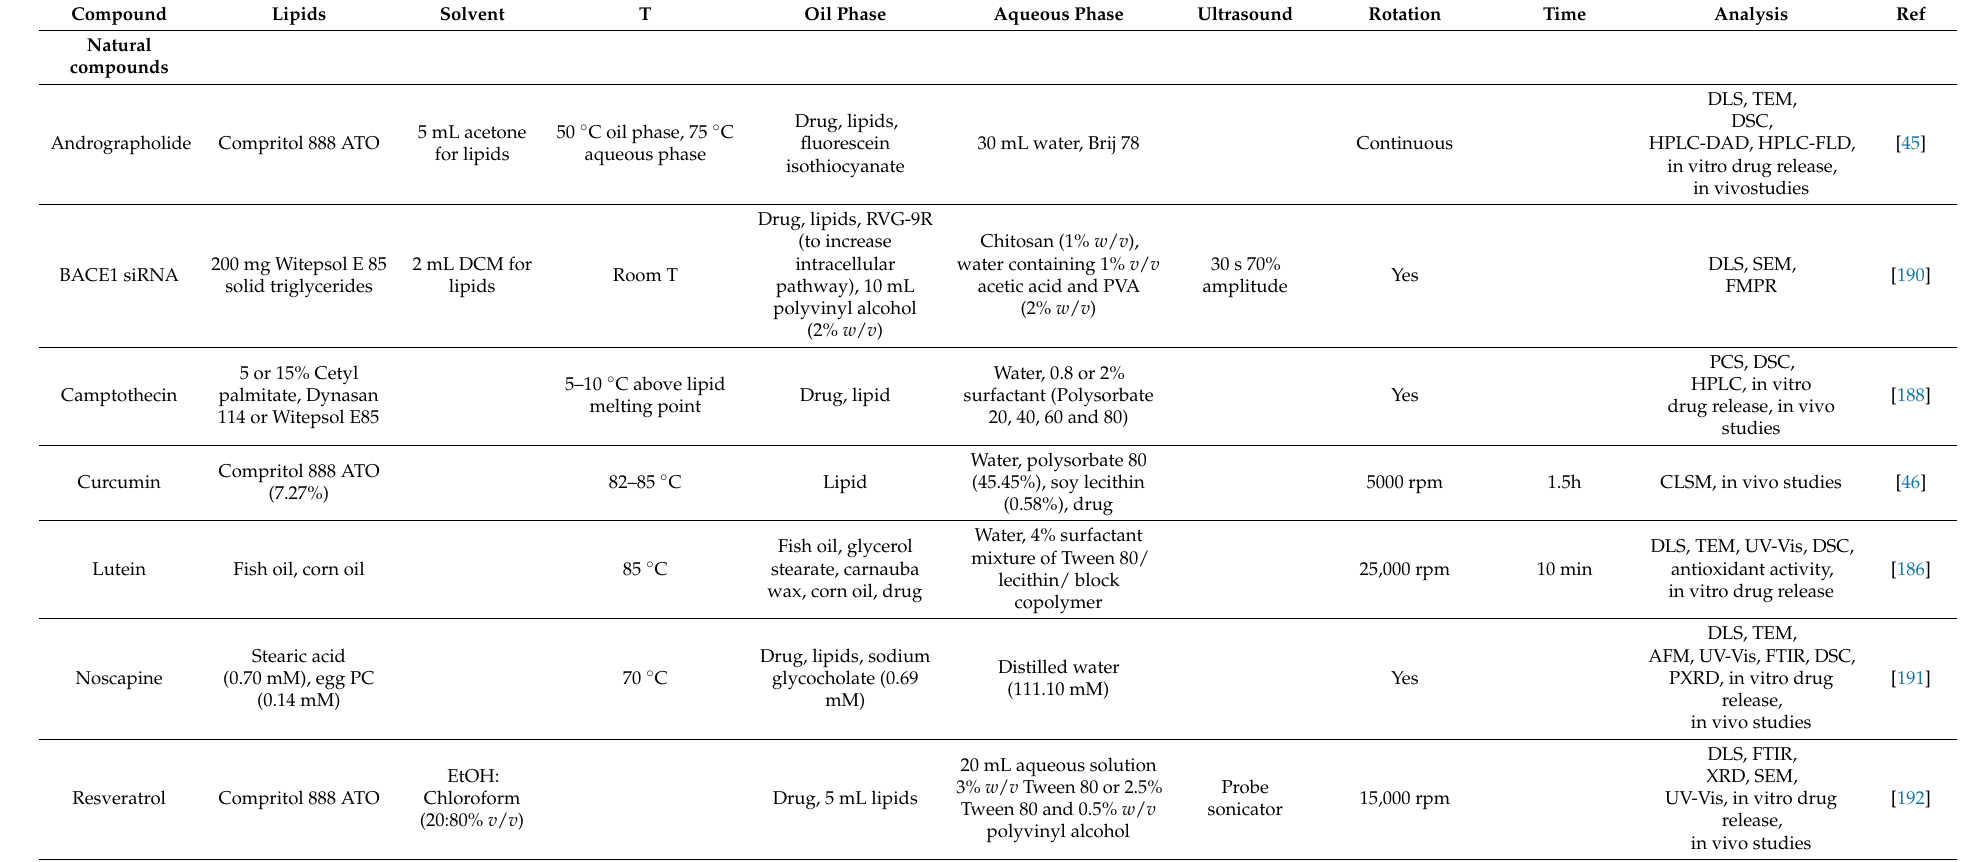
Table 4. SLNs produced to encapsulate neuroprotective